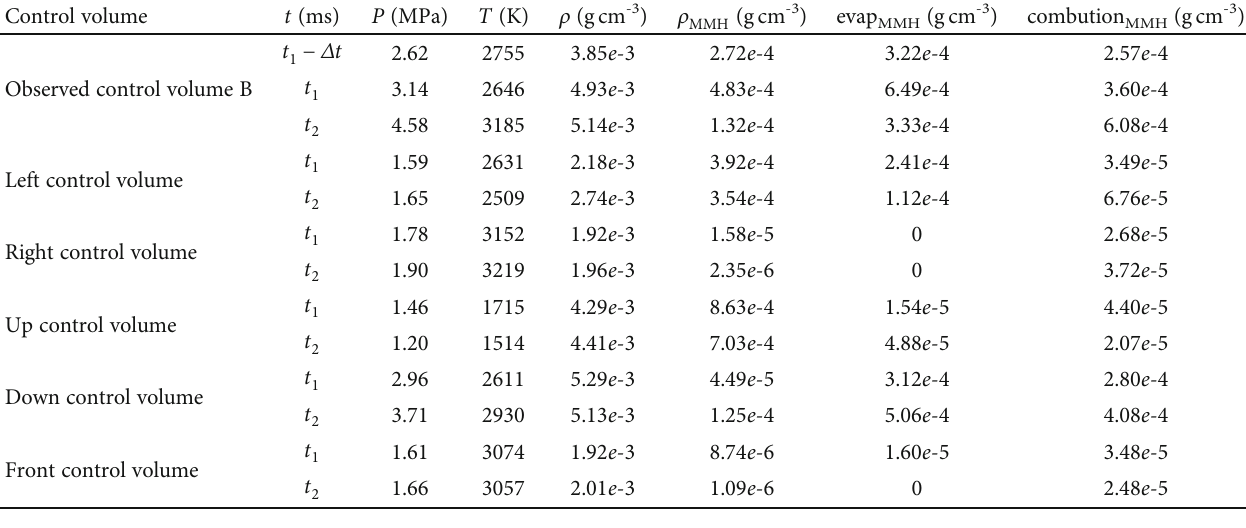
Table 3: Typical physical variables in the observed control volume and its surrounding control volumes in a time period Δ t .